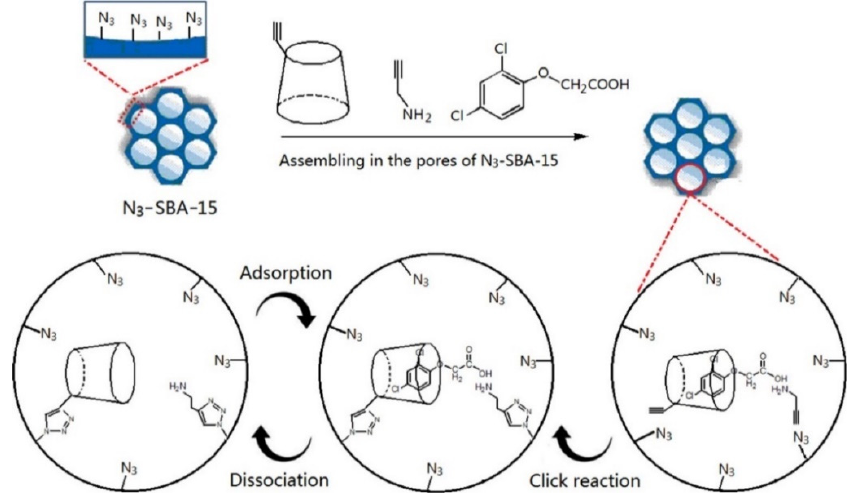
Figure 7. Schematic representation of the routes of molecular imprinting for 2,4-D. Reproduced from [83], with permission from Copyright 2016 Springer.